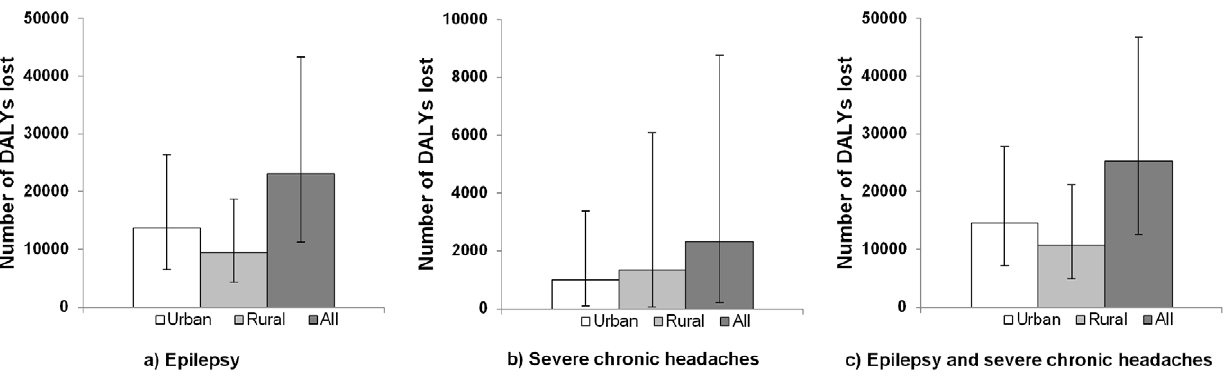
Figure 4. Annual number of DALYs lost due to NCC-associated epilepsy and severe chronic headaches in Mexico. (A) DALYs lost due to NCC-associated epilepsy. (B) DALYs lost due to NCC-associated severe chronic headaches. (C) DALYs lost due to NCC-associated epilepsy and severe chronic headaches. Note: The bar height in the figure represents the estimated number of DALYs lost. The plot whiskers represent the 95% CR.